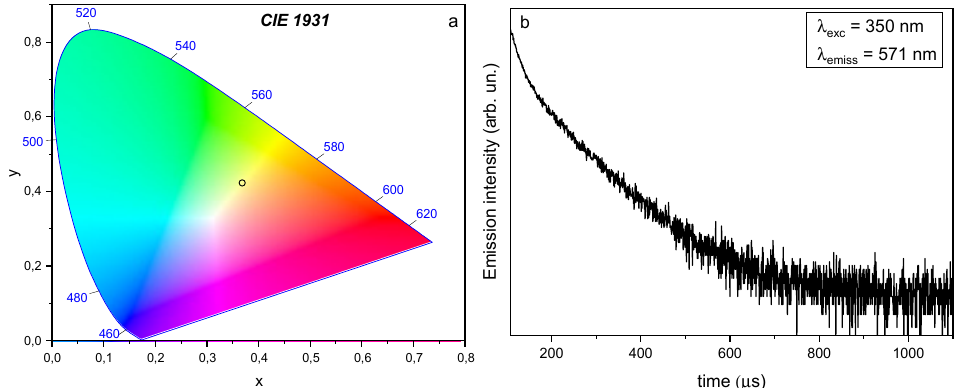
Figure 9. ( a ) CIE diagram for Ca 9 Dy(PO 4 ) 7 material upon excitation at 350 nm. ( b ) Decay time obtained for the compound Ca 9 Dy(PO 4 ) 7 upon excitation at 350 nm and by detecting the emission at 571 nm.